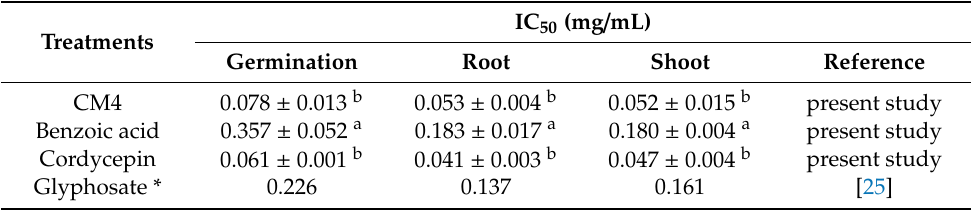
Table 3. E ff ects of CM4 fraction, BA, cordycepin and glyphosate on the germination and growth of